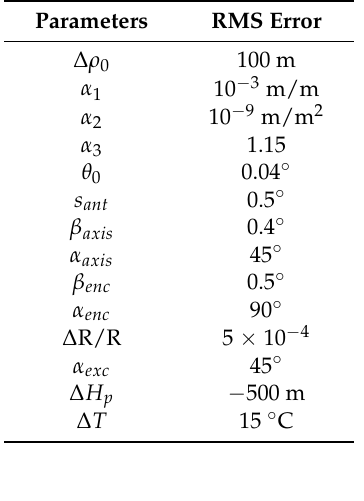
Table 1. Values of the biases used in the simulation for the radar 1.